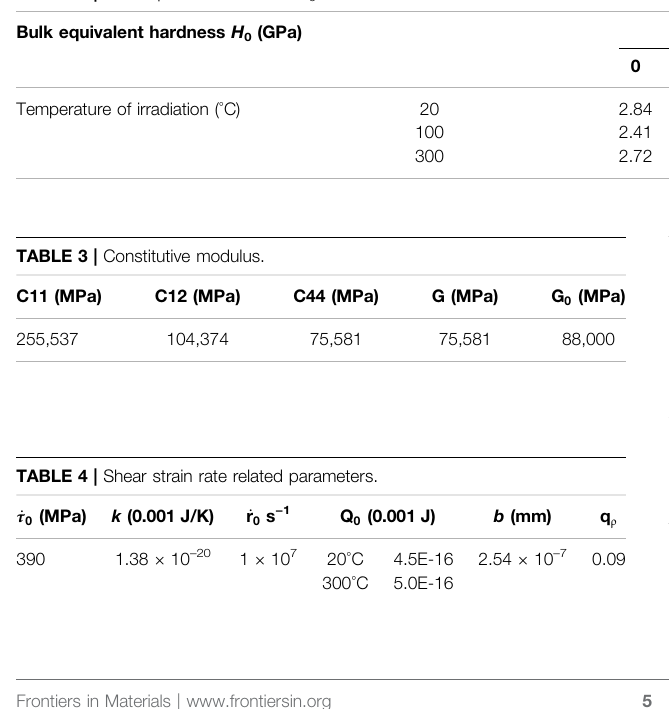
TABLE 2 | Bulk equivalent hardness H 0 of F321 stainless-steel at different irradiation temperatures and doses.